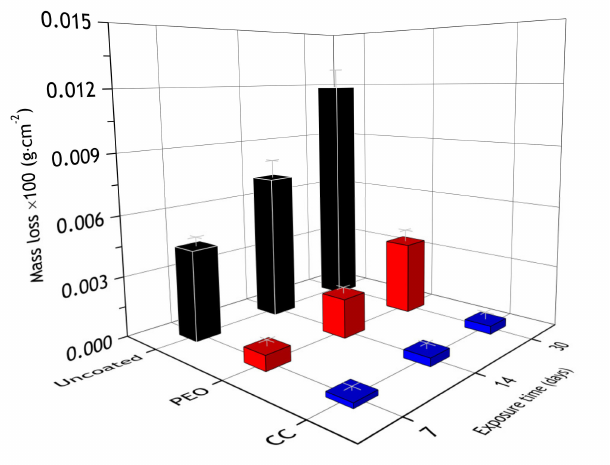
Figure 15. Mass loss of the specimens after 7, 14 and 30 days of atmospheric exposure.